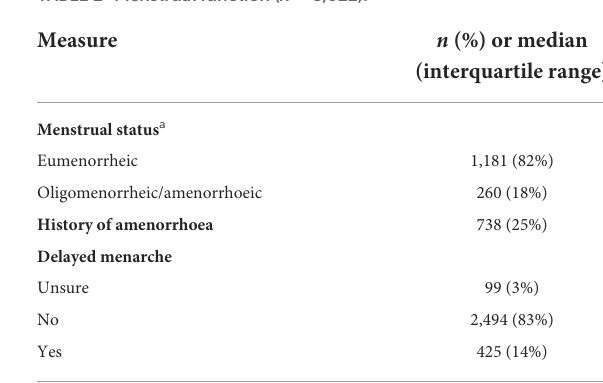
TABLE 2 Menstrual function ( n =